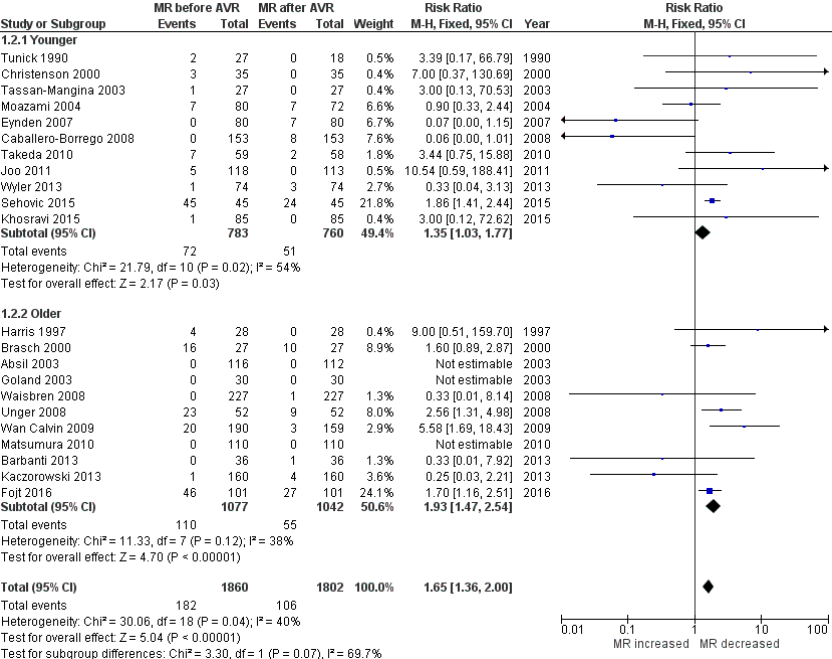
Figure 3. The forest plot of risk ratio of MR after AVR. The outcome: severe MR.